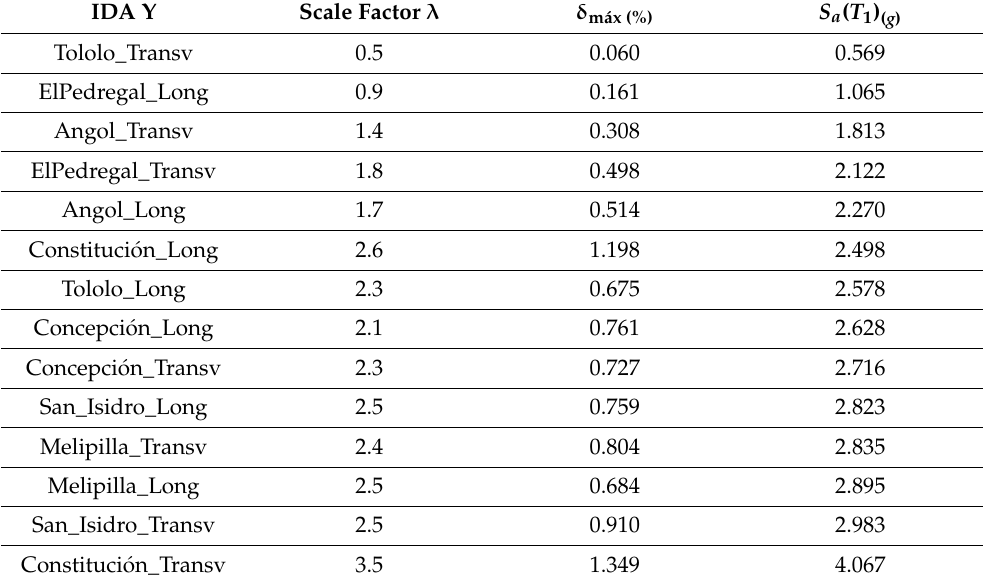
Table 4. Values of maximum drift of story δ max , spectral acceleration S a ( T 1 ) and collapse scale factor λ for the IDA curves obtained in the Y direction of the